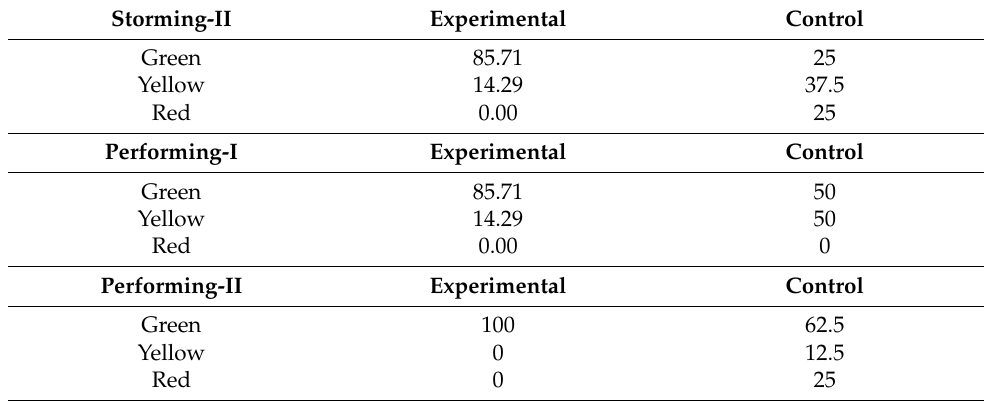
Table 6. Error percentages in each phase for teams of experimental and control groups. Storming-II Experimental